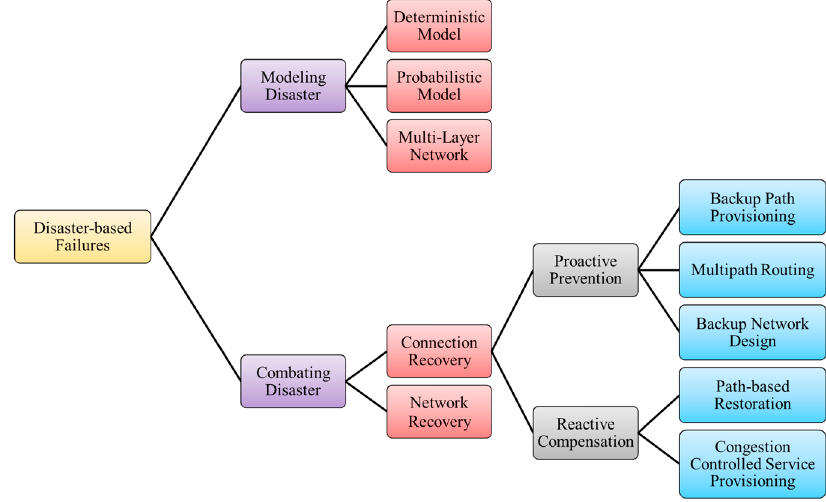
Figure 2. Overview of Disaster ‐ based Failure Survivability Mechanisms [17].